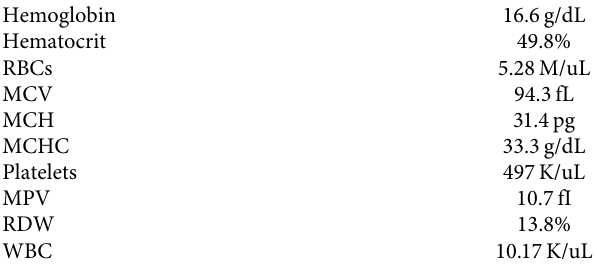
Table 1: Baseline complete blood count.